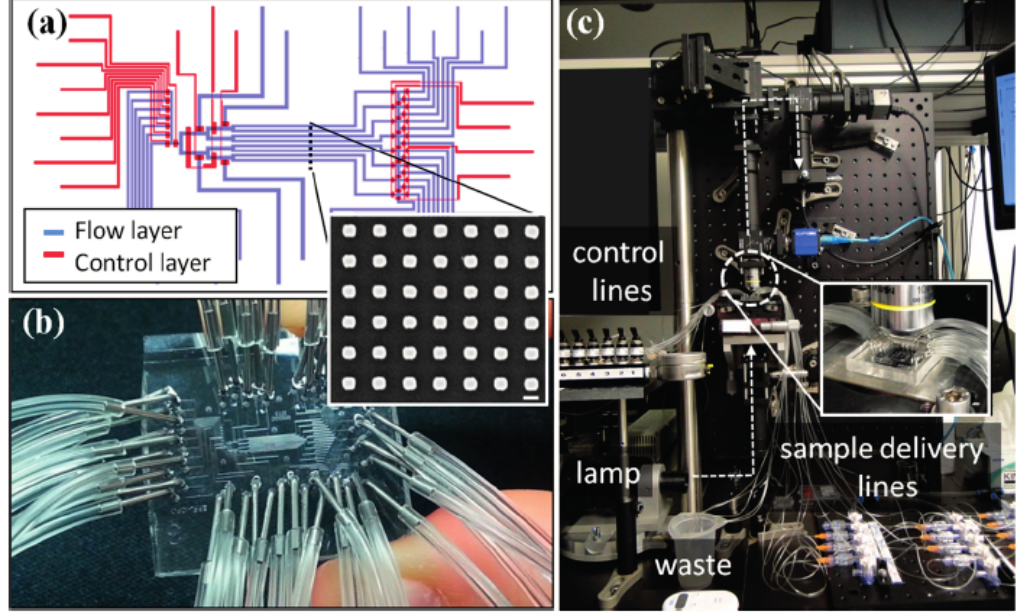
Figure 9. Schematic of the 8-channel microfluidic device containing both control and flow layers, ( a ); Each channel contains multiple “spots” of gold nanodisc arrays for multiplexed biosensing measurements, ( b ) (inset has a scale bar of 200 nm); Overview of the optical setup used to measure the plasmonic response of the nanoparticle spot arrays within the channels, ( c ) Reproduced with permission from